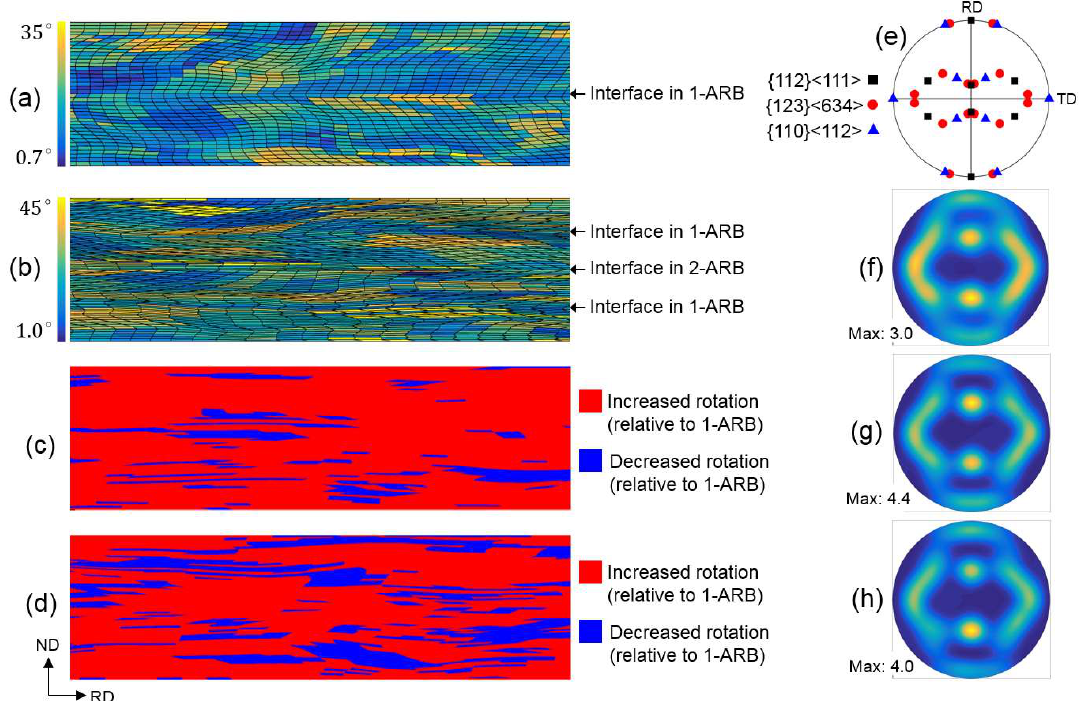
Figure 3. Distribution of crystal rotation angles and deformed FEM meshes after ( a ) 1-ARB and ( b ) 2-RevARB. Distribution of increased and decreased crystal rotation (relative to that after 1-ARB) after ( c ) 2-UniARB, and ( d ) 2-RevARB. ( e ) A {111} pole figure shows the positions of three rolling texture components. {111} pole figures after ( f ) 1-ARB, ( g ) 2-UniARB, and ( h ) 2-RevARB.